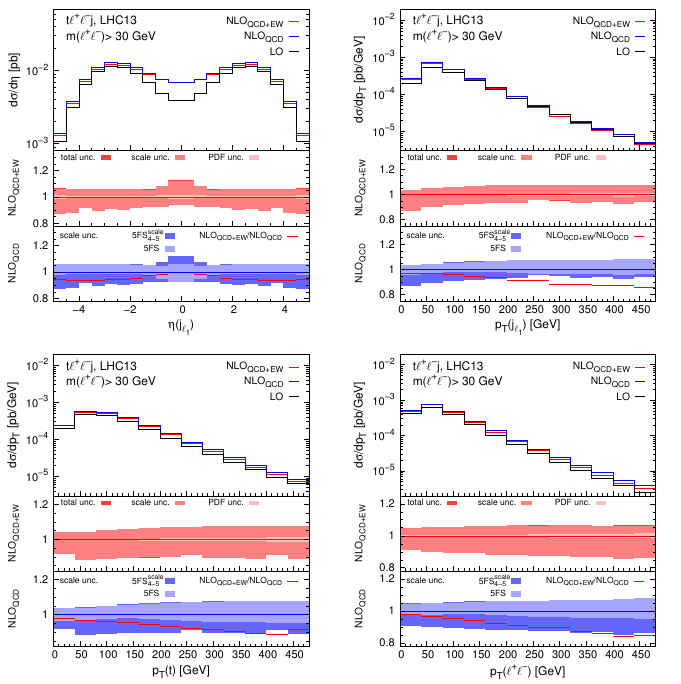
Figure 7 . NLO QCD+EW predictions for t‘ + ‘ (cid:0) j (\inclusive"). The layout of the plots is the same of (cid:12)gure